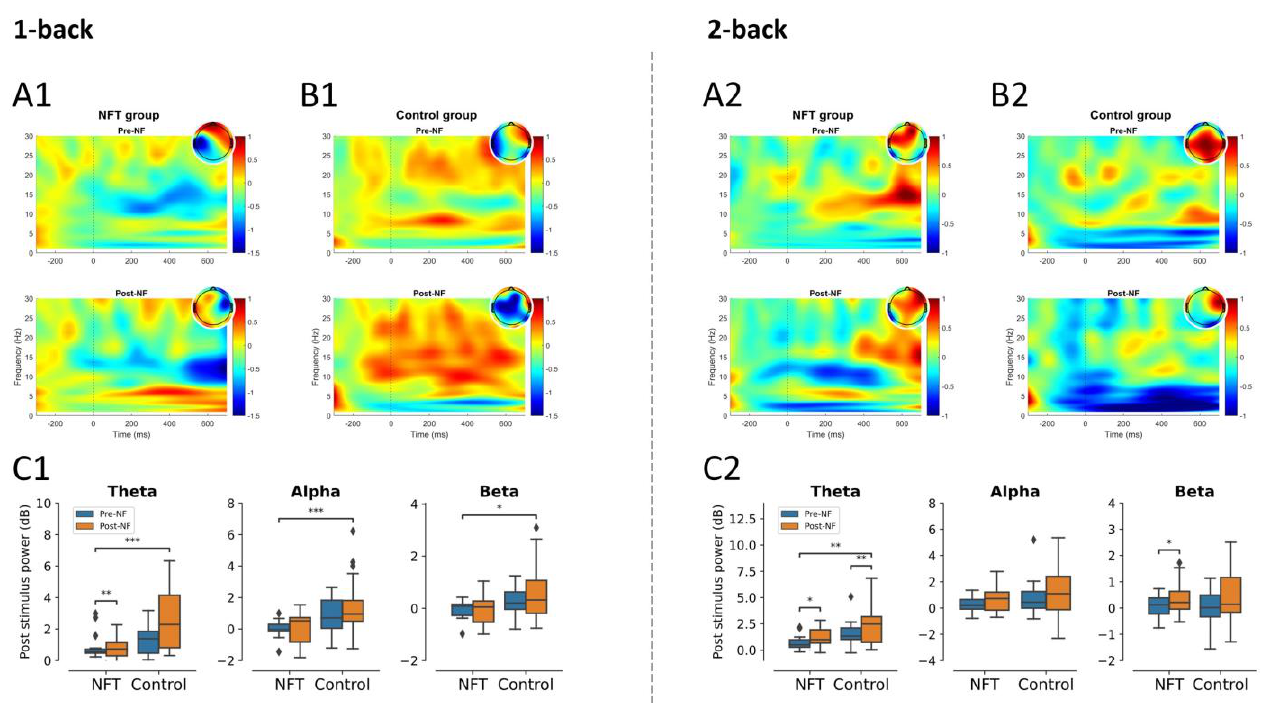
Figure 8. Post-stimulus power occipital lobe (* p < 0.05, ** p < 0.005, *** p < 0.0005): 1-back post- stimulus power in ( A1 ) NFT group and ( B1 ) control group; 2-back post-stimulus power in ( A2 ) NFT group and ( B2 ) control group. Post-stimulus power in different EEG bands within each group in ( C1 ) 1-back and ( C2 ) 2-back conditions. The colour bar of the TF plots represents the value of EEG power in dB scale. The diamond shape in the box plots represents the outliers in the data.